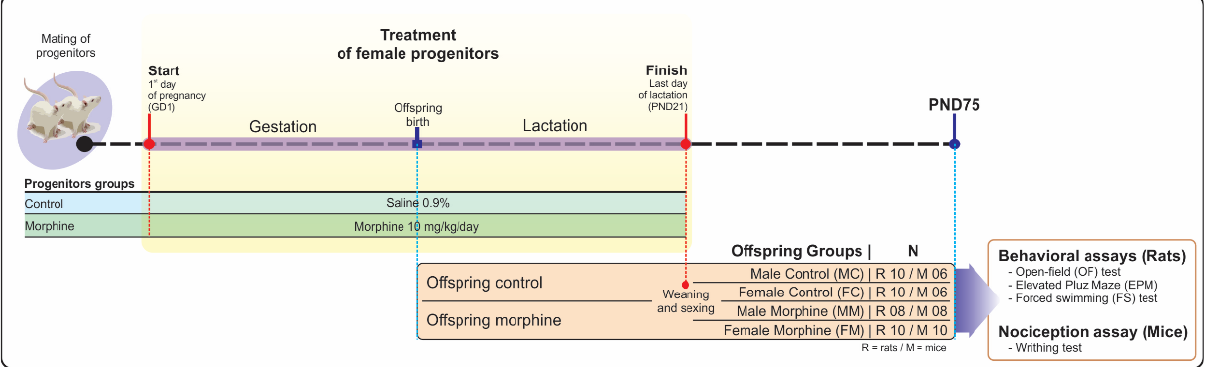
Figure 1. Experimental